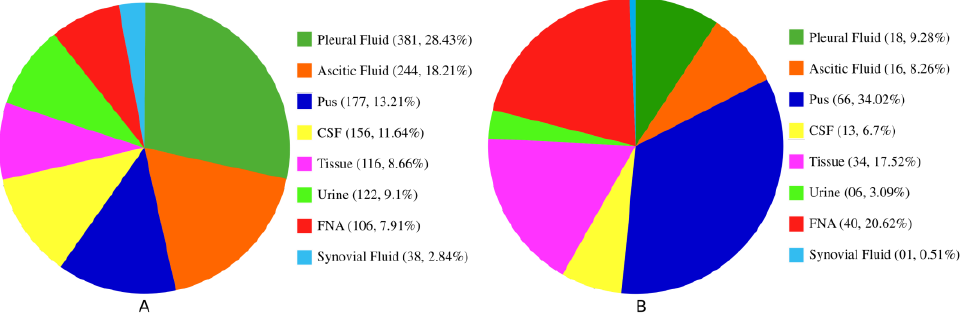
Figure 1. Distribution of specimen types ( A ) and the number of positive cases ( B ) among the enrolled EPTB specimens.